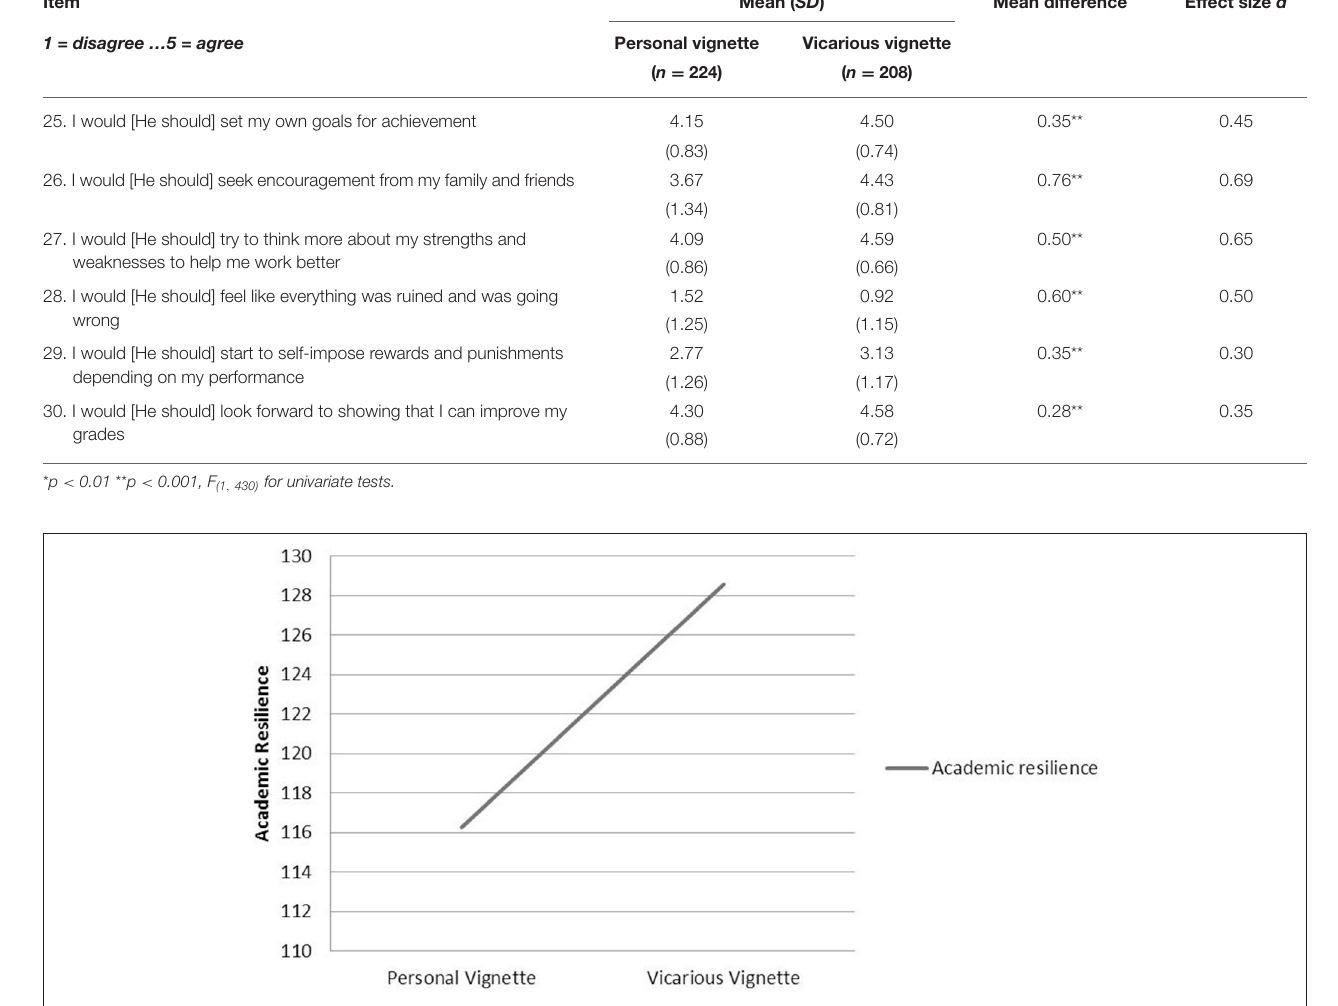
FIGURE 2 | Mean academic resilience by vignette